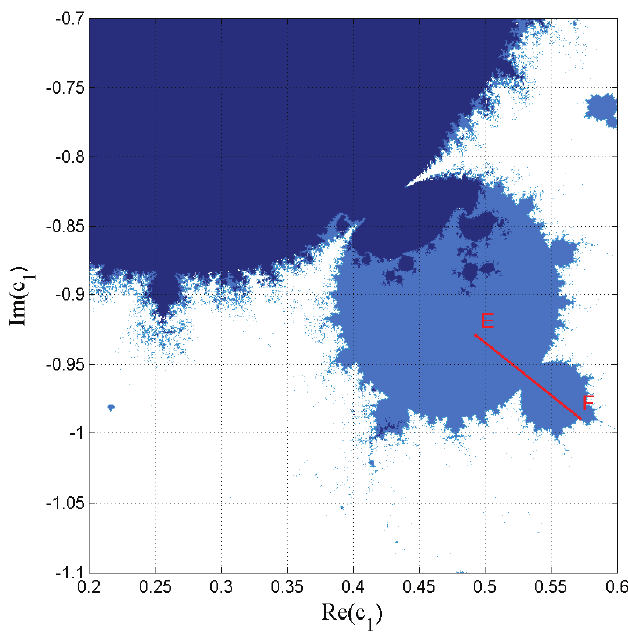
Figure 6. The local enlarged region of Figure 4b.